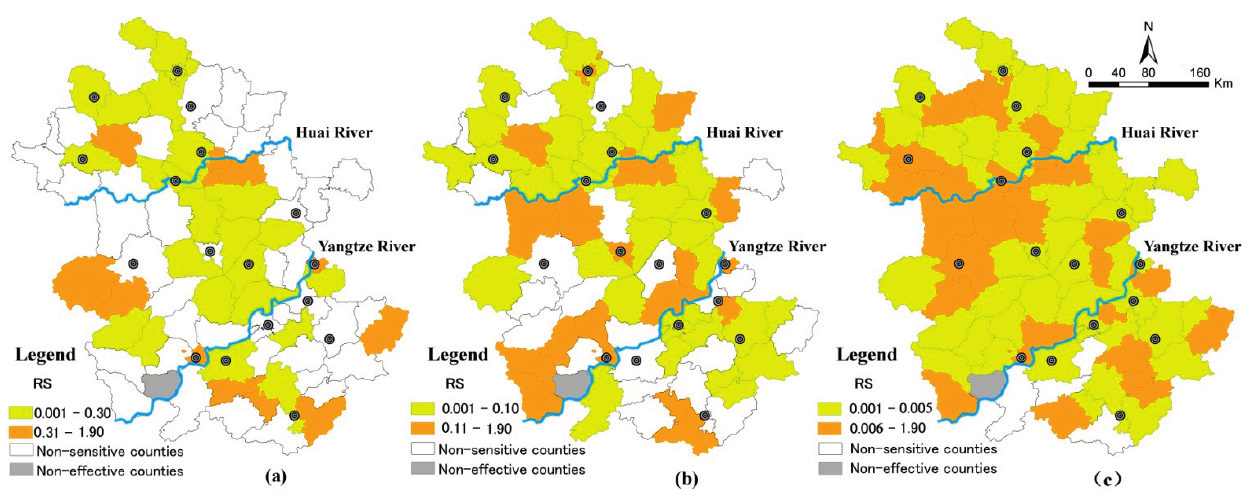
Figure 5. The spatial distribution of RS for dysentery in Anhui Province: ( a ) RS to temperature; ( b ) RS to precipitation; ( c ) RS to absolute